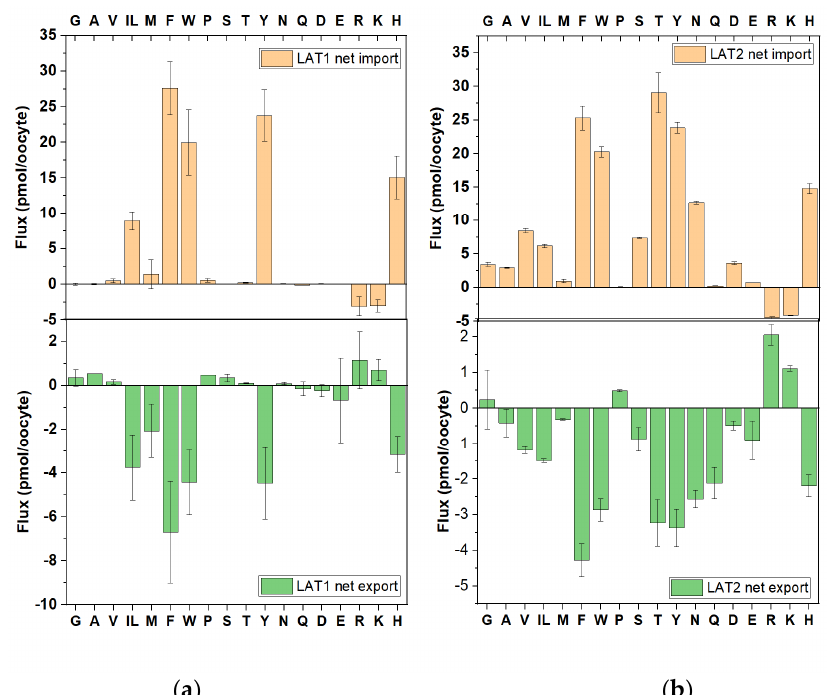
Figure 3. Analysis of antiport via LAT1 and LAT2 . Oocytes expressing 4F2hc–LAT1 ( a ) or 4F2hc– LAT2 ( b ) were incubated with labelled and unlabelled amino acids as described in Figure 2a. Net import (positive numbers) and net export (negative numbers) are shown. Isoleucine and leucine cannot be separated by LC–MS and are shown as IL. The activity of oocytes expressing 4F2hc alone was subtracted, resulting in apparent oppositely-directed transport for some amino acids. Preferred substrates of LAT2 for import and efflux were Thr, Phe, Tyr, Trp, His and Asn. Smaller fluxes were detected for Ala, Val, Ile/Leu and Ser. Methionine has been shown to be a strong substrate when presented alone, but its flux was minimal in a complex mixture. Glutamate and aspartate are not substrates of LAT2 and instead were most likely